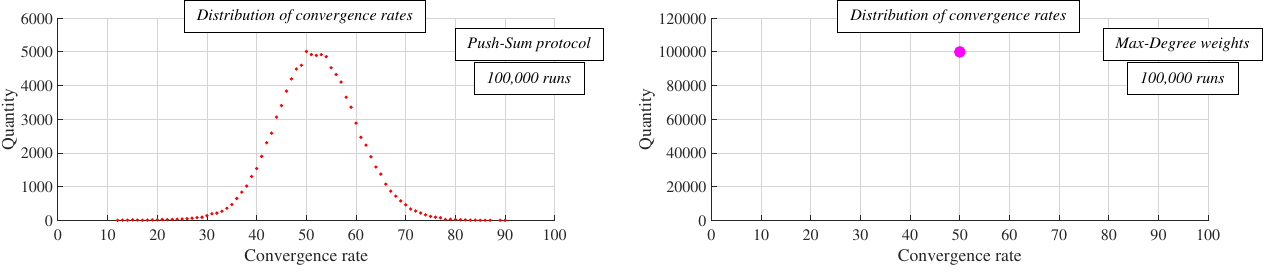
Figure 7. Comparison of gossip Push-Sum protocol with deterministic Max-Degree weights algorithm—distribution of convergence rate over 100,000